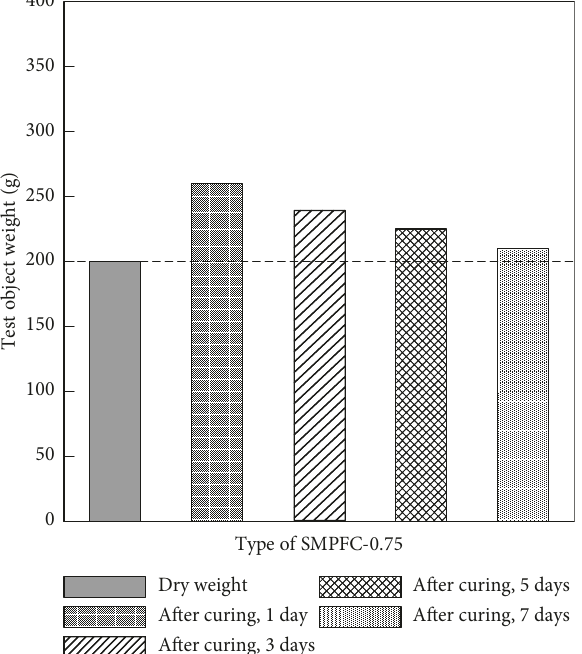
Figure 13: Test results of moisture content (SAP